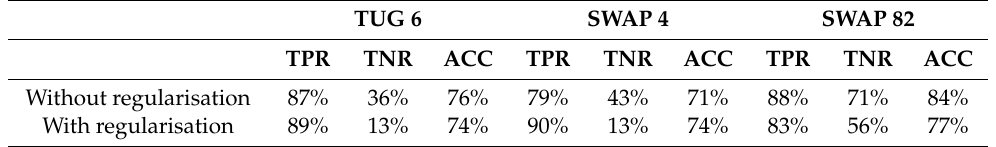
Table 7. Sensitivity (true-positive rate, TPR), specificity (true-negative rate, TNR), and accuracy (ACC) for the faller classification using the TUG 6, SWAP 4, and SWAP 82 tasks with different regularisation approach in ANN learning (averaged over number of neurons and number of